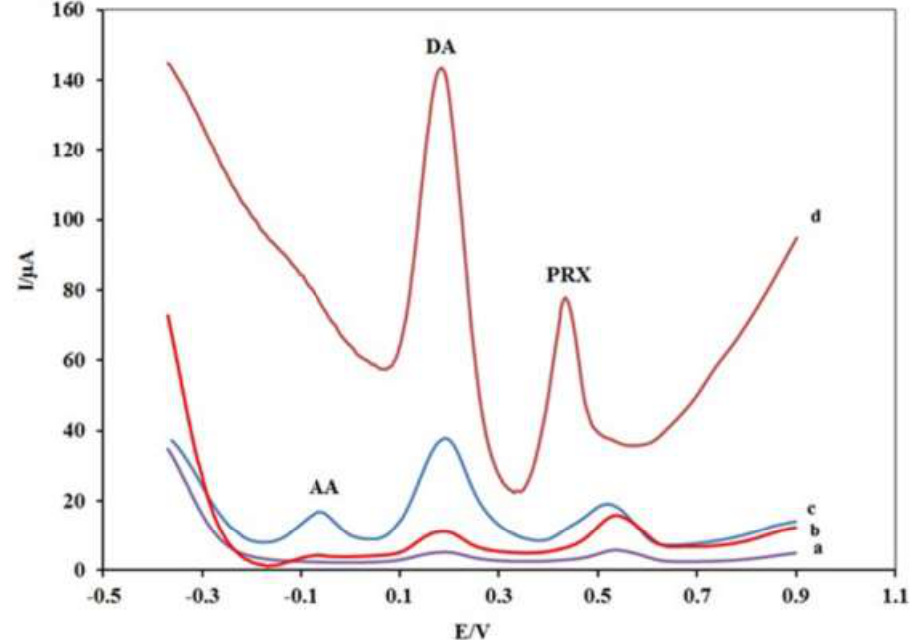
Fig. 5. The DPV voltammograms of CPE (a), MWCNTs/CPE (b), TOHS/MWCNTs/CPE (c) and PGA/TOHS/ MWCNTs/CPE (d) for 100 µM DA PRX in presence of 0.4mM AA in 0.1M ammonia buffer solution (pH 7.0) at scan rate of 100 mV s -1